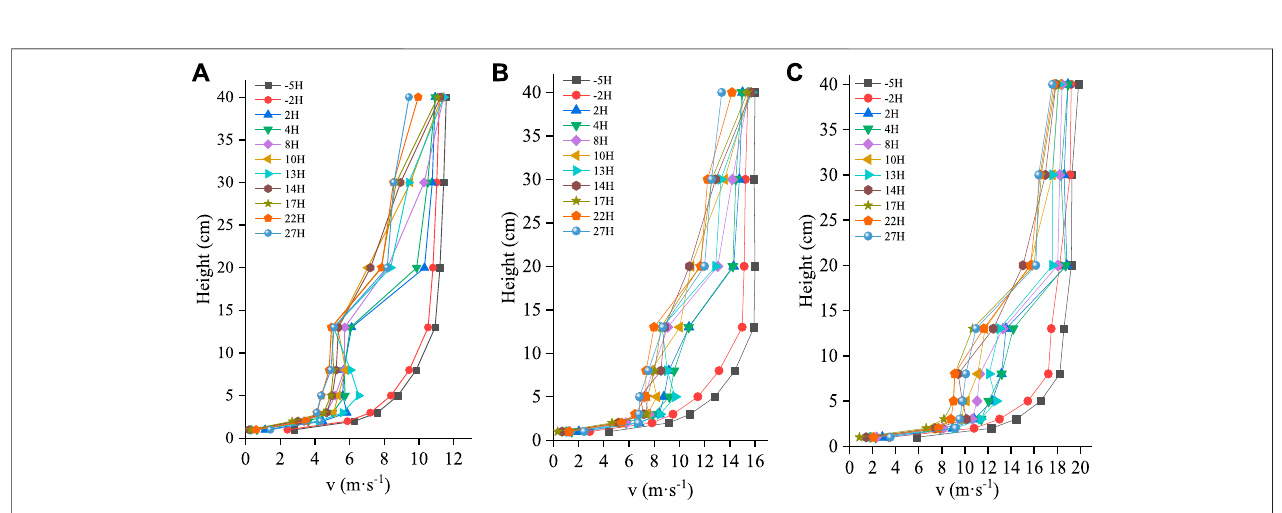
FIGURE 11 | Variation law of wind velocity pro fi le at different positions of three rows of windbreak forest belts under different incoming wind velocities. (A) : V = 8 m · s − 1 , (B) : V = 12 m · s − 1 , (C) : V = 16 m · s − 1 .